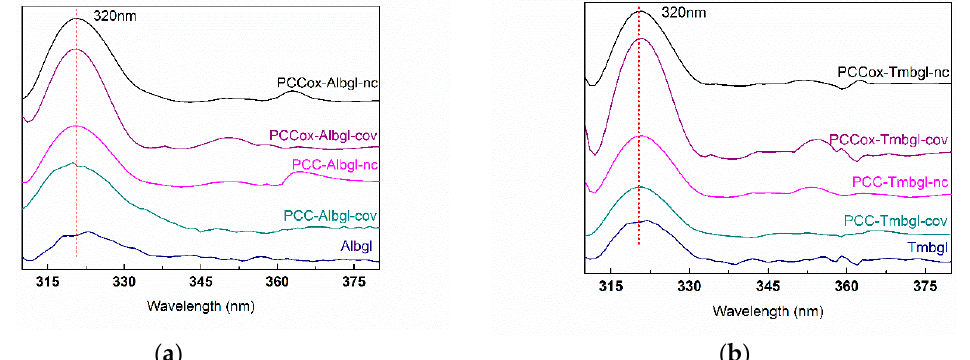
Figure 5. Fluorescence spectra of ( a ) free and immobilized Albgl on PCC and PCCox. ( b ) Free and immobilized Tmbgl on PCC and PCCox.